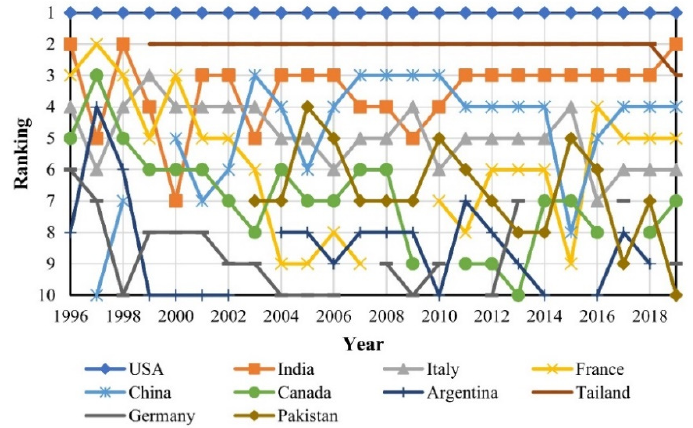
Figure 5. The top 10 countries in terms of the number of export partners over the years.